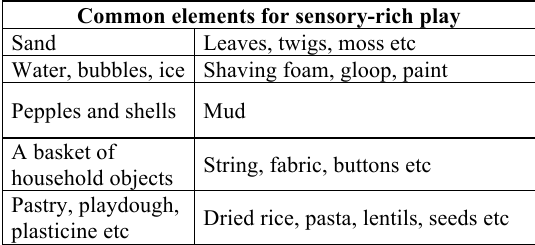
Table 2. Examples of sensory-rich play